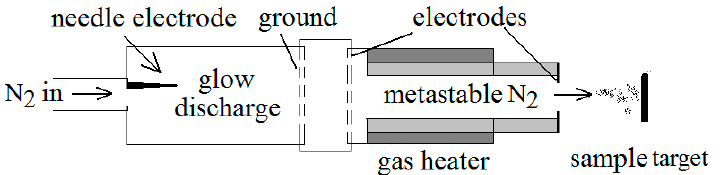
Figure 1. A schematic of the temperature-controlled DART Metastable Nitrogen